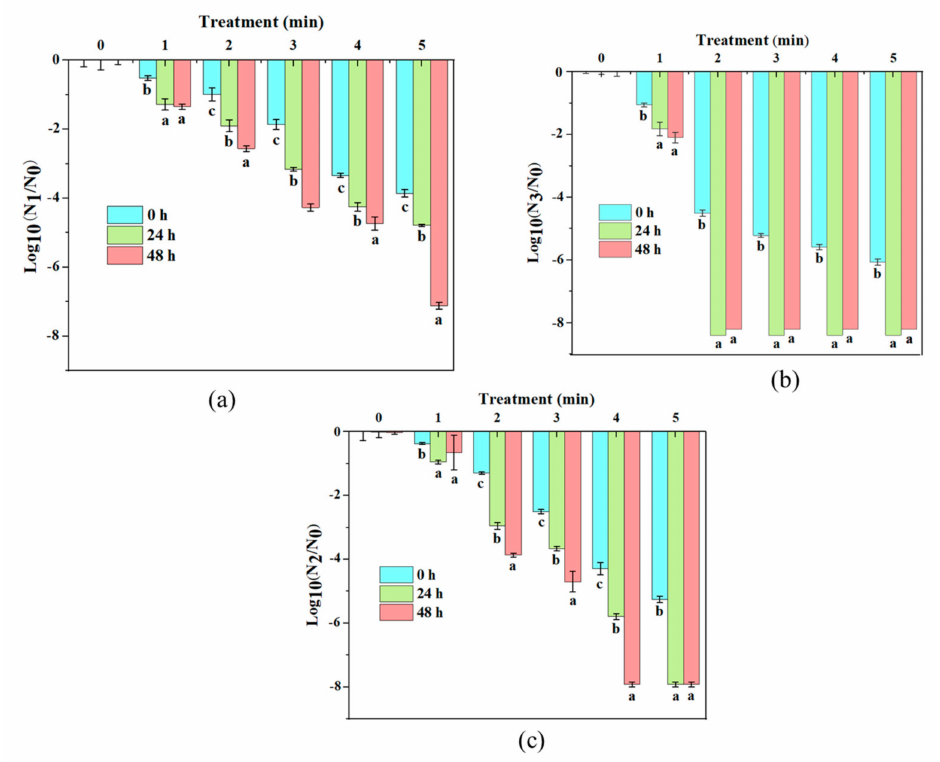
Figure 3. Inactivation of S. typhimurium at different storage time after plasma treatment: ( a ) 40 V, ( b ) 50 V, ( c ) 60 V. Different letters of each treatment time indicate the significant difference ( p <